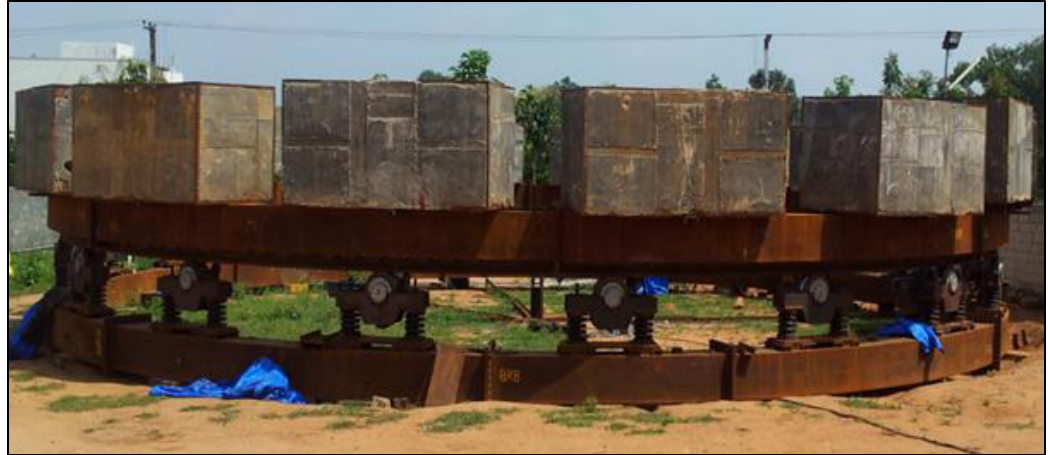
Figure 8. Ring beam and drive assembly test setup at